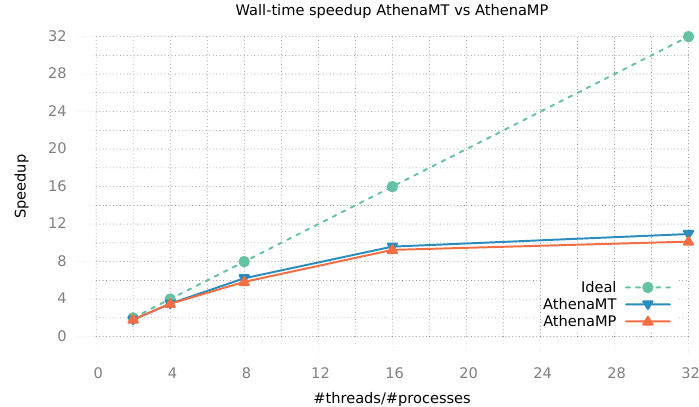
Figure 5: Wall-time speedup of AthenaMT (blue) vs. AthenaMP (orange), compared with the ideal linear